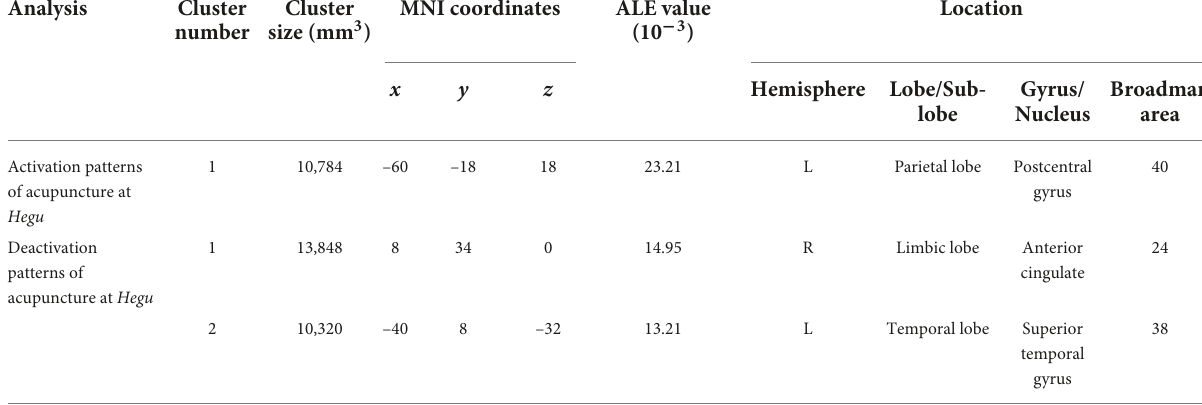
TABLE 2 Activation likelihood estimation (ALE) meta-analysis results of acupuncture at Hegu.